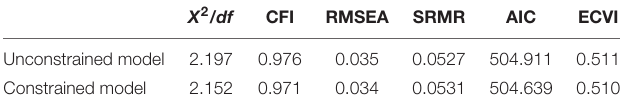
TABLE 4 | The comparison of unconstrained model between constrained